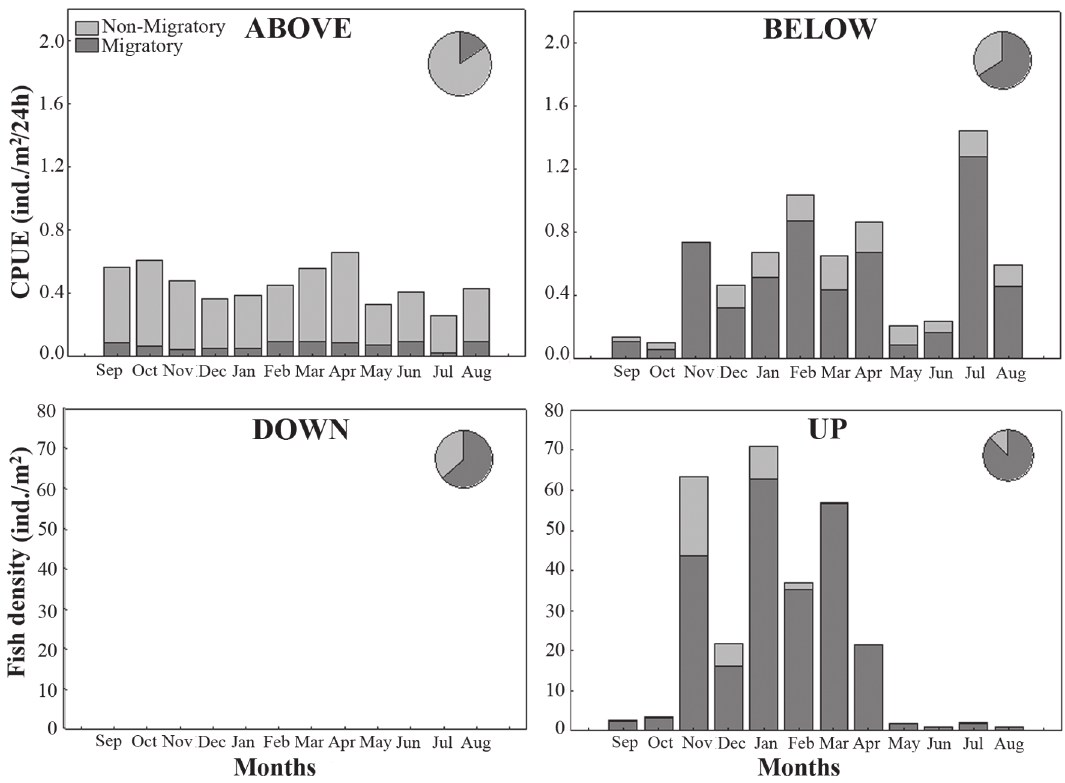
Fig. 3. Temporal trends in fish abundance recorded around the dam (ABOVE and BELOW; fish/m 2 of net /24 h) and inside the ladder (DOWN and UP; fish/m 2 ). Small charts indicate the numerical contribution (%) of migratory and non-migratory species over the entire